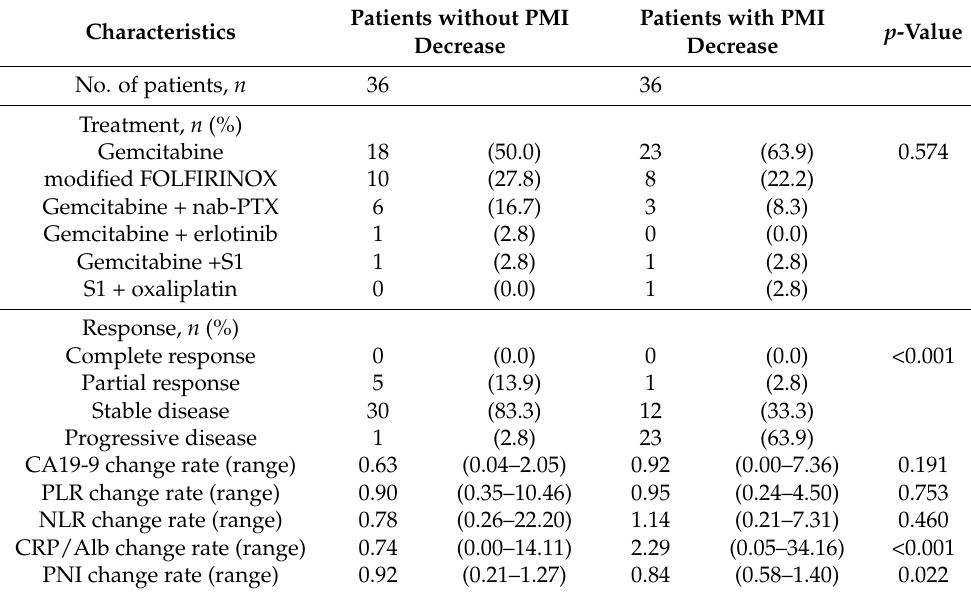
Table 4. Comparison of the clinical outcomes of the patients without or with PMI